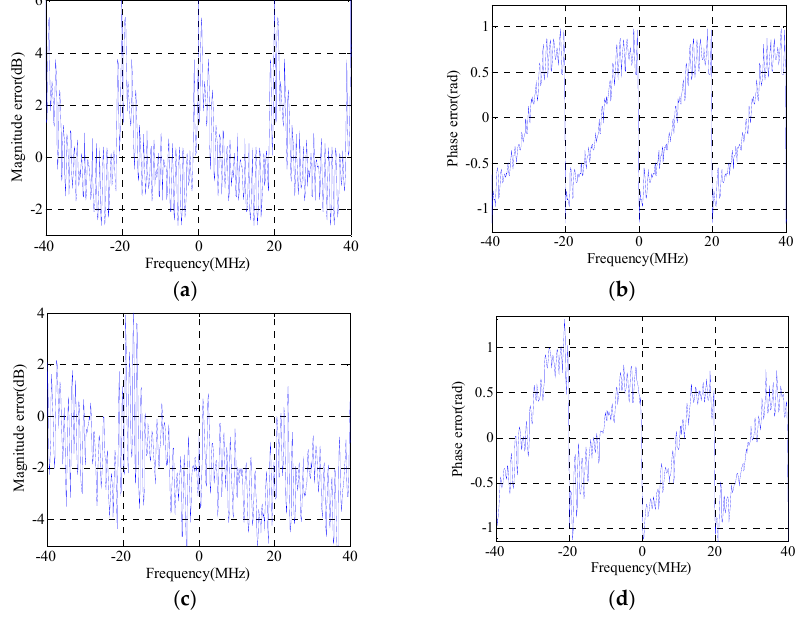
Figure 5. Estimated MEPE: ( a ) estimated magnitude error by GLPP; ( b ) estimated phase error by GLPP; ( c ) estimated magnitude error by the proposed method; and ( d ) estimated phase error by the proposed method.